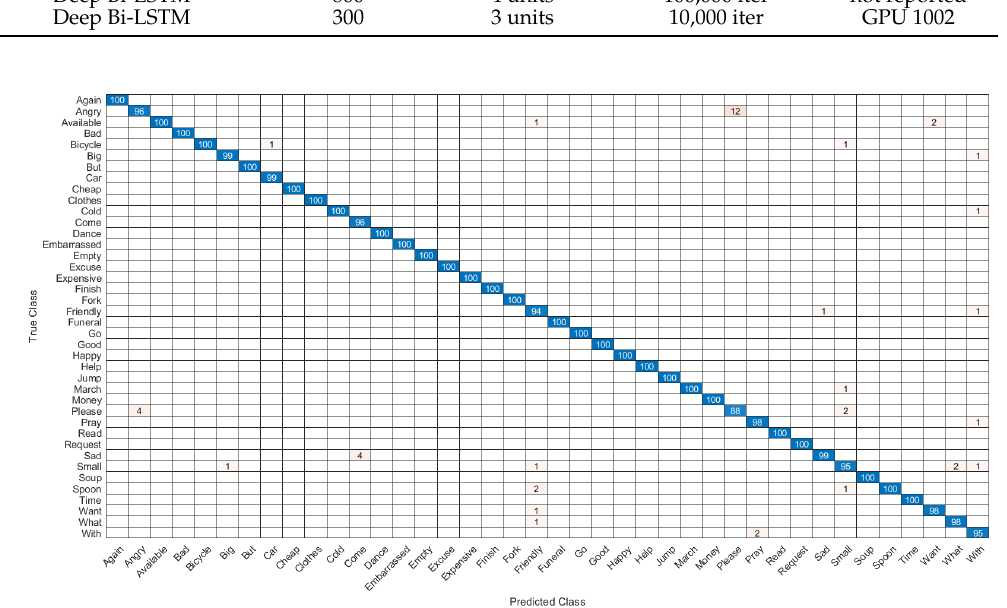
Figure 10. Confusion matrix of the recognition performance of double-hand dynamic ASL words with Adam optimization.